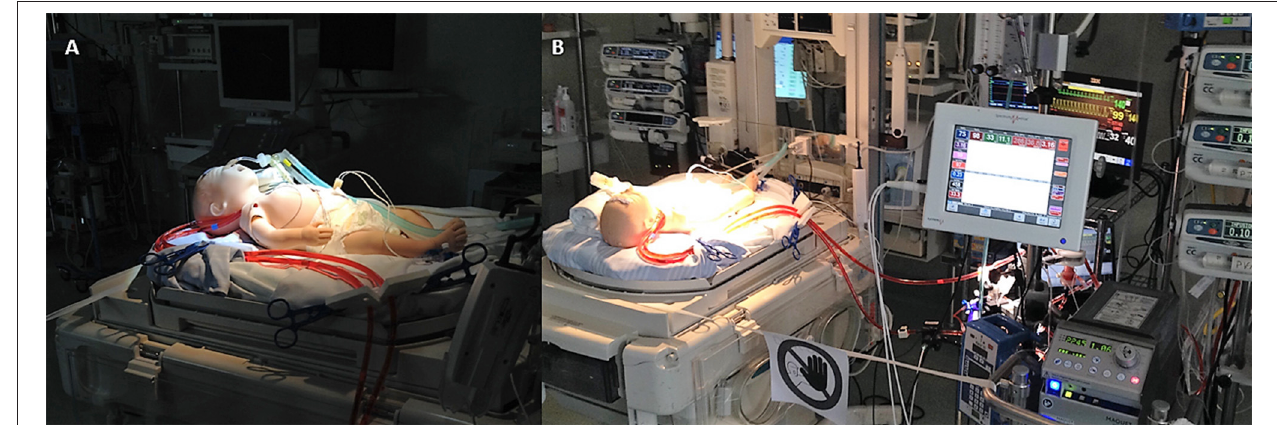
FIGURE 3 | Modified mannequin for ECMO simulation. (A) Particular of the cannulas. (B) HiFi simulation setting.